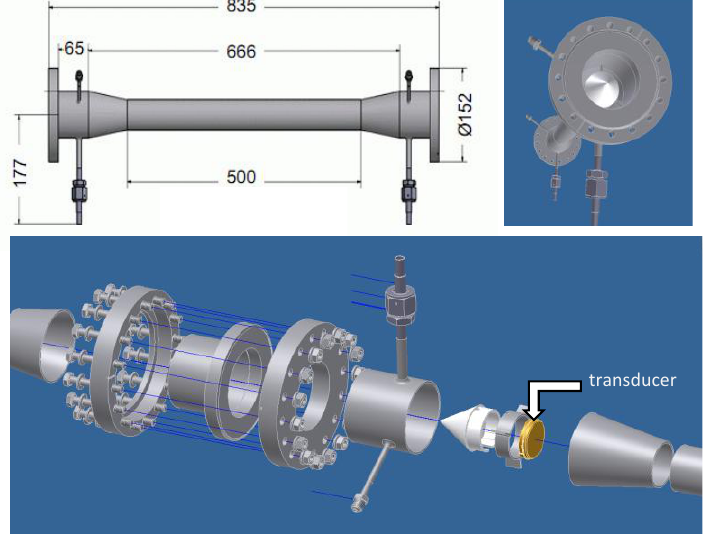
F leaks into the N environments surrounding the 3 8 2 leaks into the IBL gas volume. 2